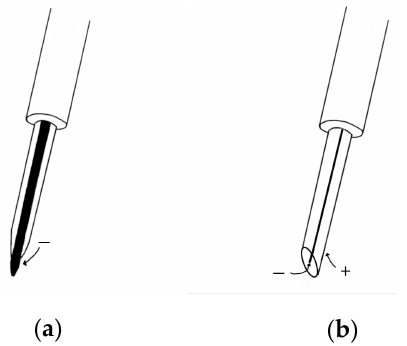
Figure 4. ( a ) Monopolar needle electrode; ( b ) concentric needle electrode.